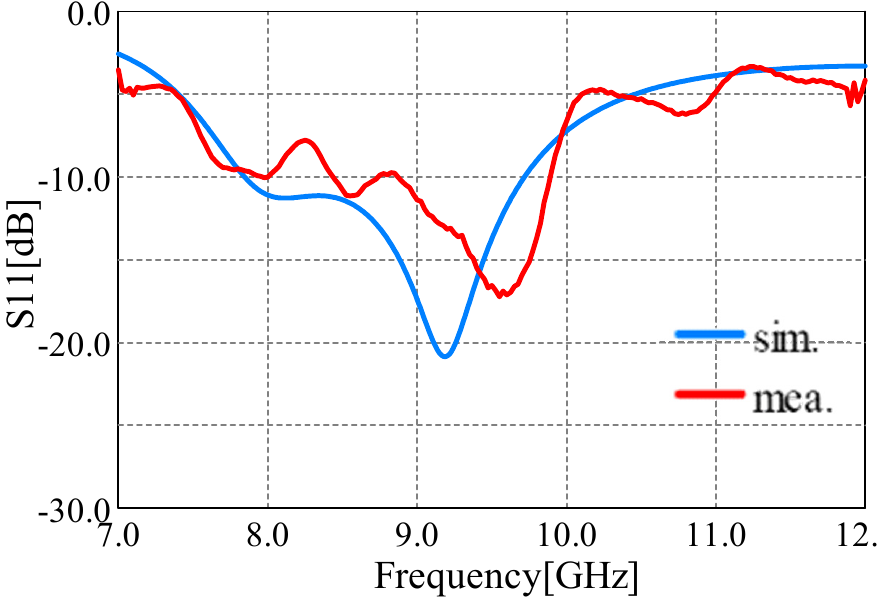
Figure 5. Simulation and measurement results of the S11 for the reflection characteristics.